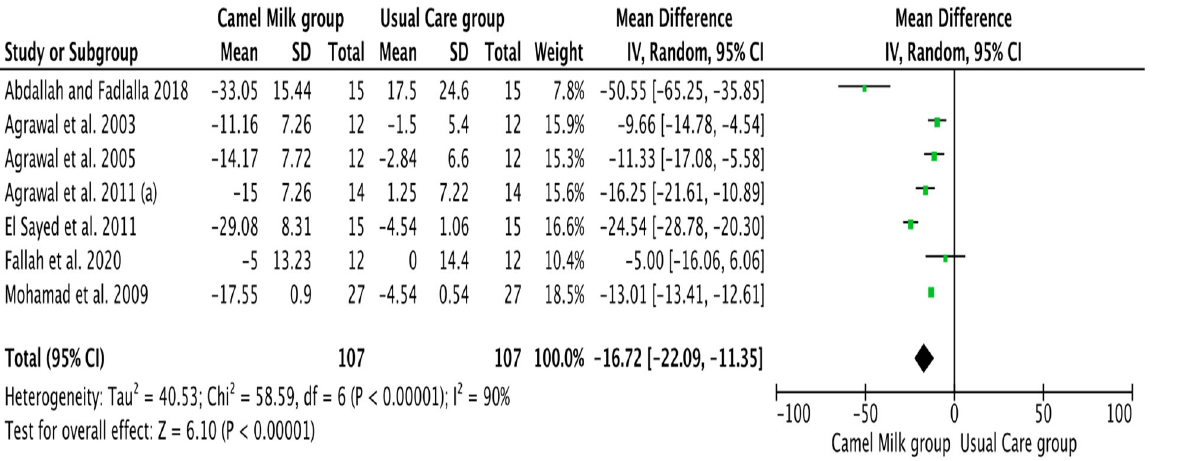
Figure 4. Forest plot for the effect of CM intake on fasting blood glucose (FBG). Note: Mostafa and Al ‐ Musa, 2014 (a) for T1DM and (b) for T2DM.